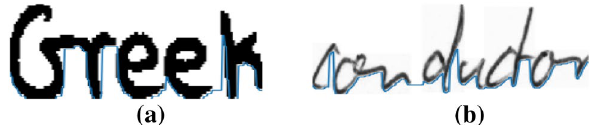
Fig. 5 Two examples of the estimated lower profiles of the word images. The blue curves represent the lower